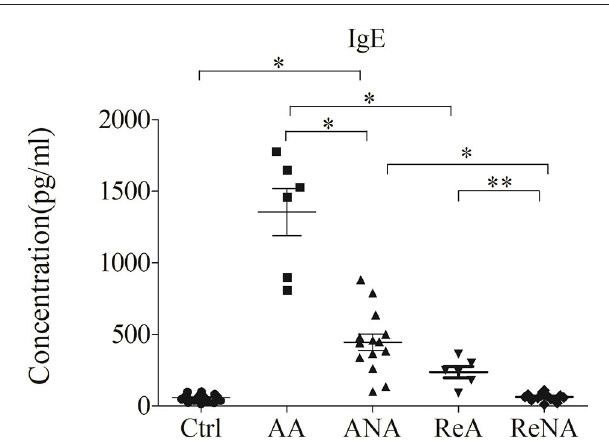
FIGURE 1 | Children with atopic and non-atopic INS have increased serum levels of IgE. Here and below: all data are shown as means ± SDs; * P < 0.05 and ** P > 0.05; and abbreviations are healthy control (Ctrl, n = 20), active phase atopic (AA, n = 6), active phase non-atopic (ANA, n = 14), remission phase atopic (ReA, n = 6), and remission phase non-atopic (ReNA, n = 14).